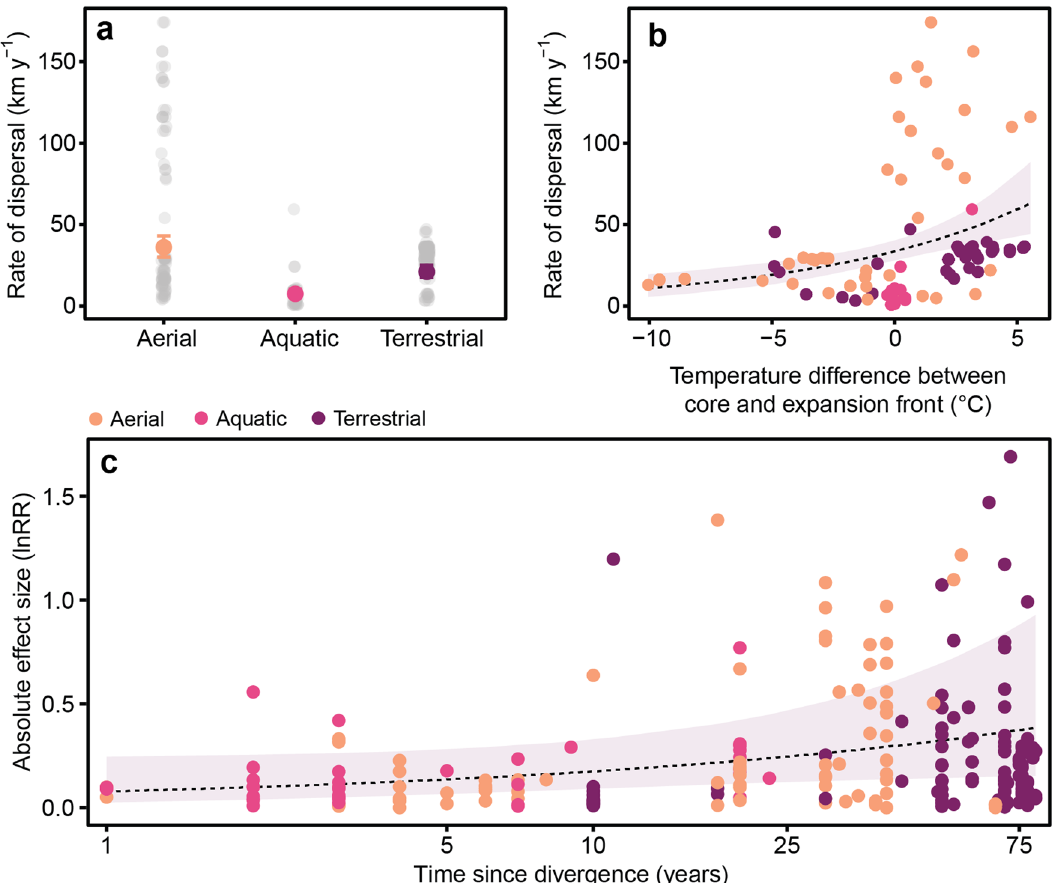
Fig. 5 Relationship of temperature on dispersal rate, and the time since populations diverged on the magnitude of change in physiological traits. a Differences in the rate of dispersal (km y − ¹) between dispersal modes, and b the relationship between the annual mean air temperature difference between the range core and dispersal front (°C) and the rate of dispersal. c Absolute effect size (lnRR) showing the in fl uence of time since populations diverged on the magnitude of change in physiological traits. Data in the plot are presented as average model estimate ±95% CI, and grey points represent raw data. Data in plots b and c are represented as the regression estimate ±95% CI, and individual data points are coloured by dispersal